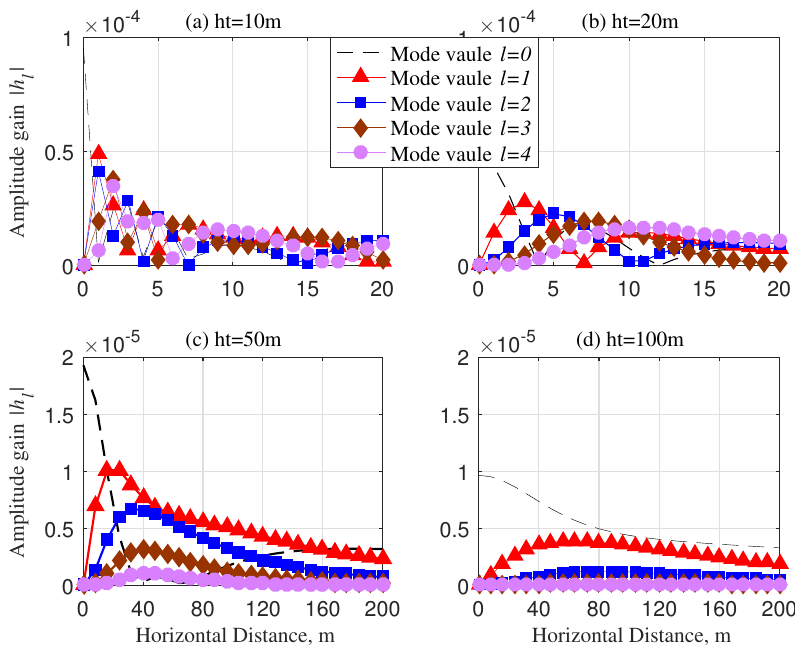
Figure 4. Amptitude gain | h l | , SNR = 20 dB and R = 20 λ : ( a ) h t = 10 m; ( b ) h t = 20 m; ( c ) h t = 50 m; ( d ) h t = 100 m.